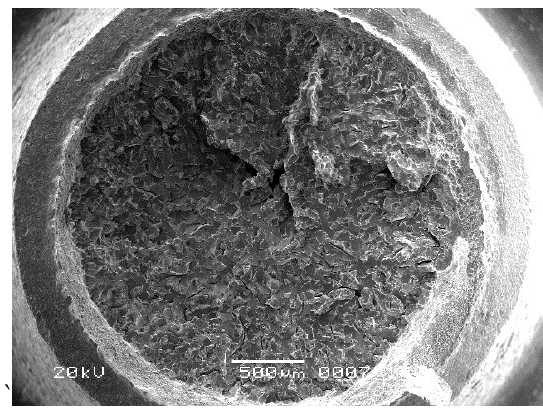
Figure 8. Low magnification of fracture surface in torsion simulation test (500 μ m).